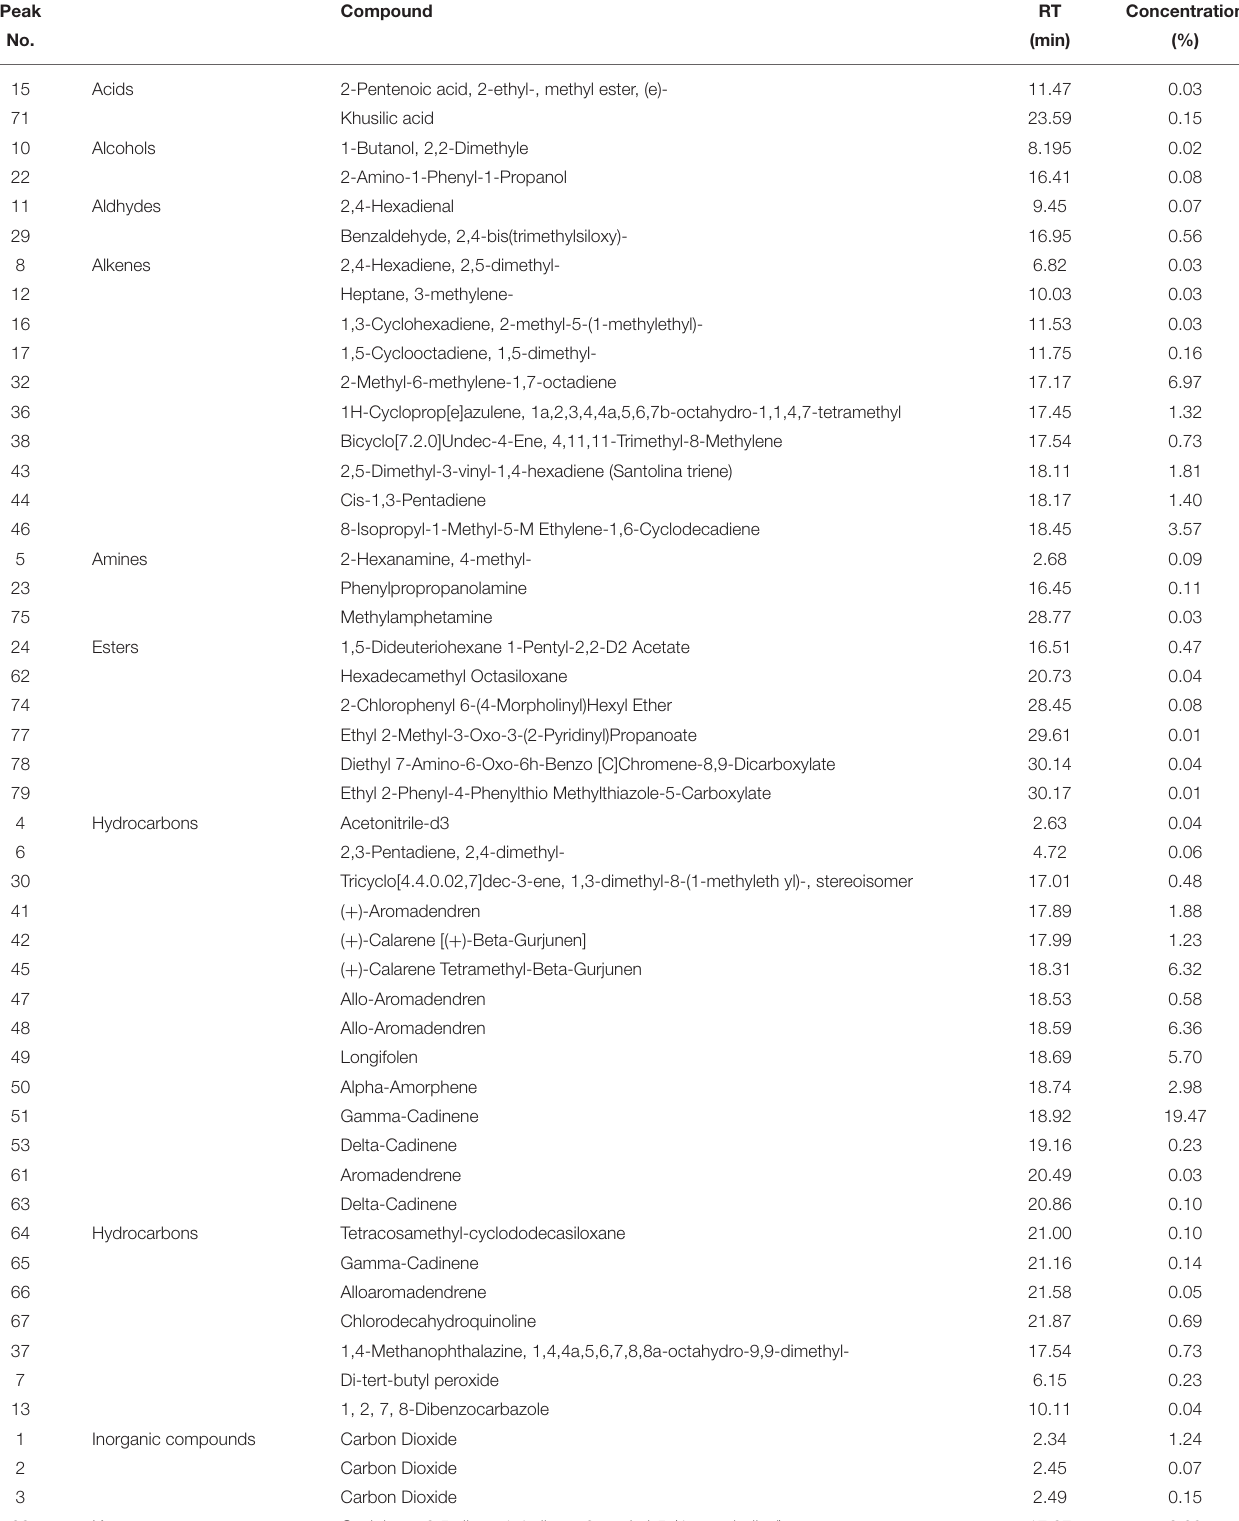
TABLE 4 | GC-MS analysis showing the VOCs profile of PGPF strain Trichoderma harzianum KNU1. Peak Compound RT Concentration